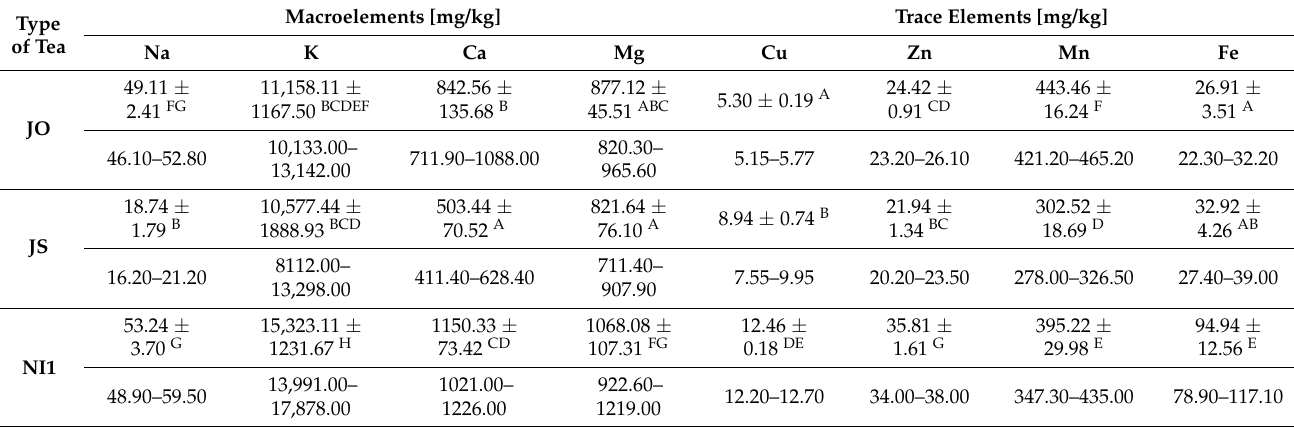
Table 1. The average content of macro- and trace elements in black teas from various origins. Each value represents mean ± SD and range. Means not sharing the same letter in a column are significantly different at p ≤ 0.05; Tukey post-hoc test. Type of